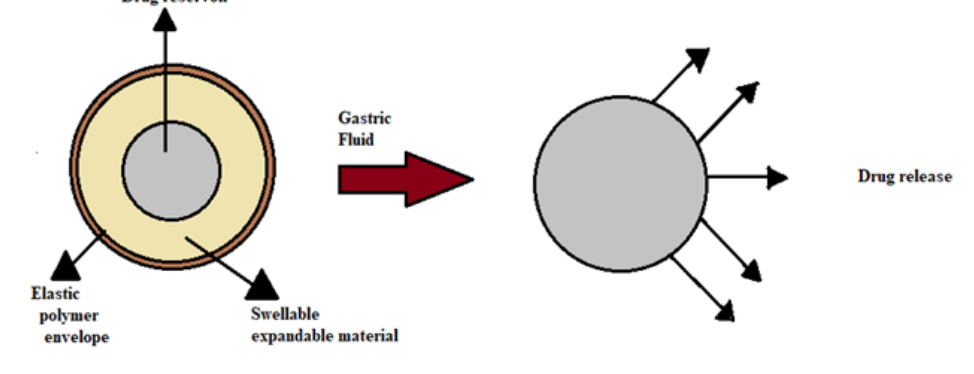
Fig. 5. Swellable system of